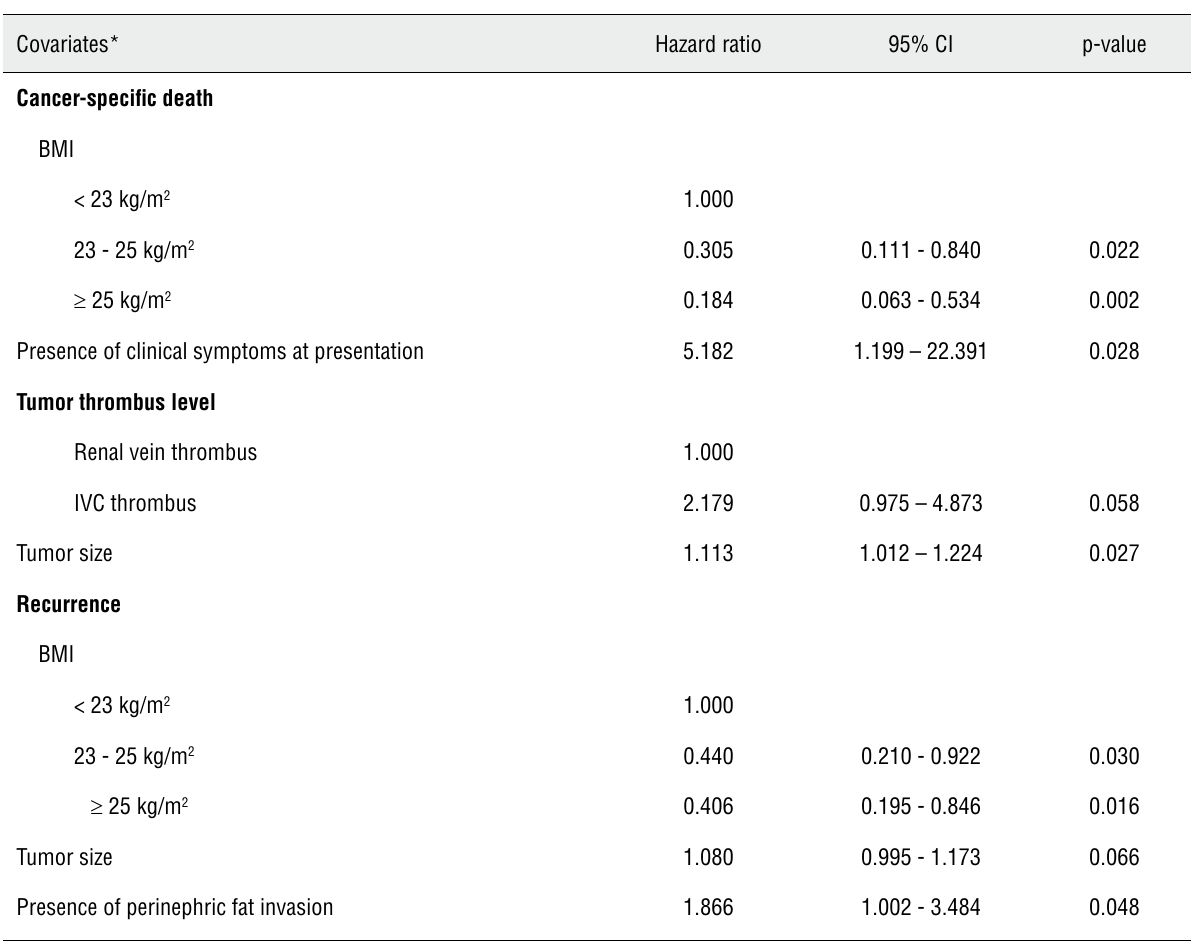
Table 3 - Multivariate Cox proportional hazard analysis for cancer-specific death and recurrence in non-metastatic RCC (pN0/xM0) patients.